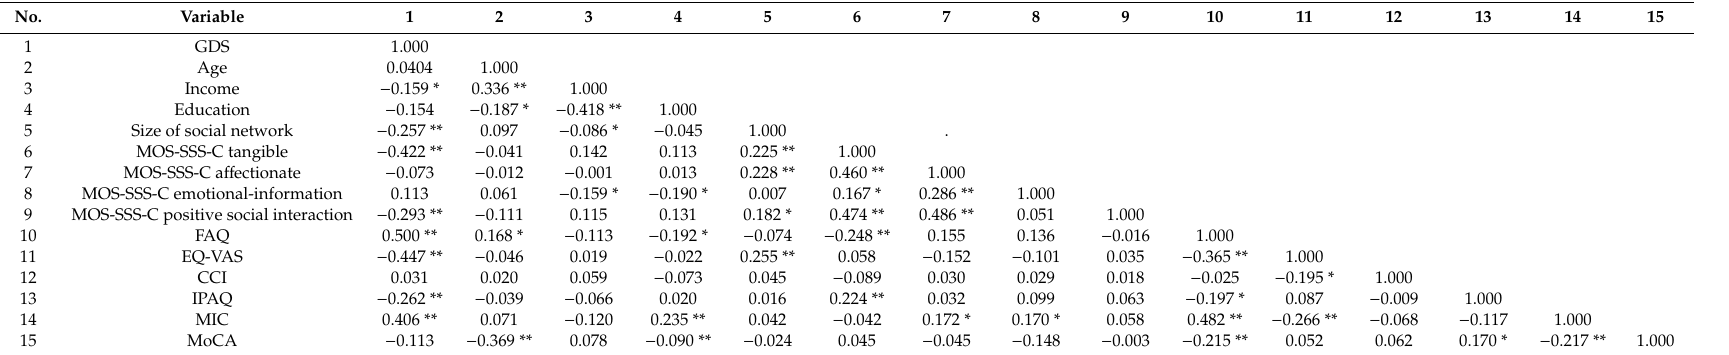
Table 2. Correlations of socio-demographic features, lifestyle factors, disease-related factors, and depressive symptoms in MCI ( N = 154).